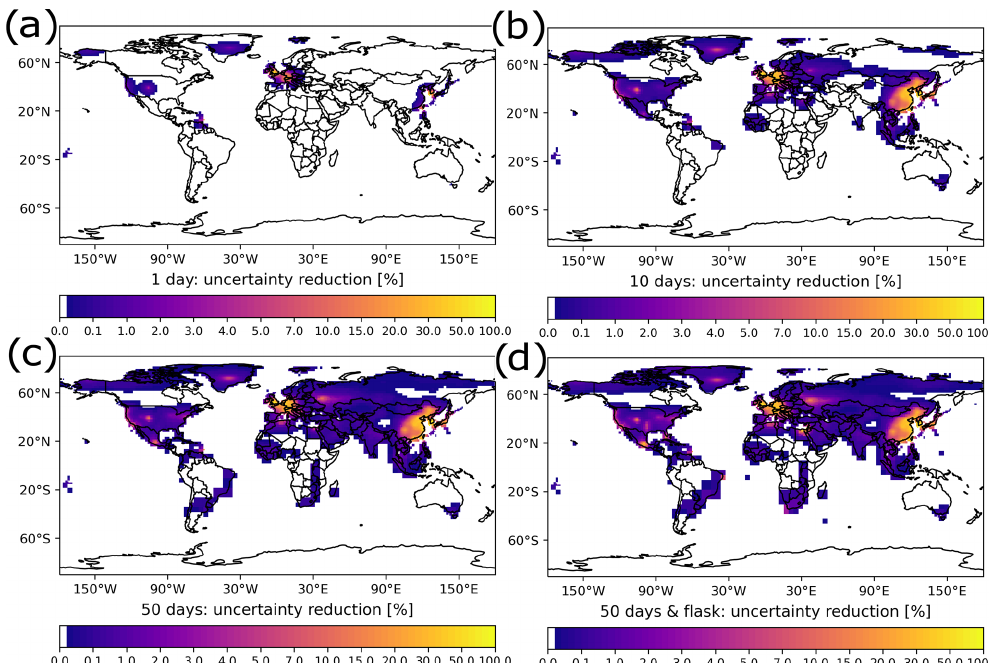
Figure A3. Relative uncertainty reductions (1 − u post /u pri ) calculated with the inversion by using the GDB method and a backward simulation period for (a) 1, (b) 10, and (c) 50d and (d) for the 50d case in which flask measurements were also included.